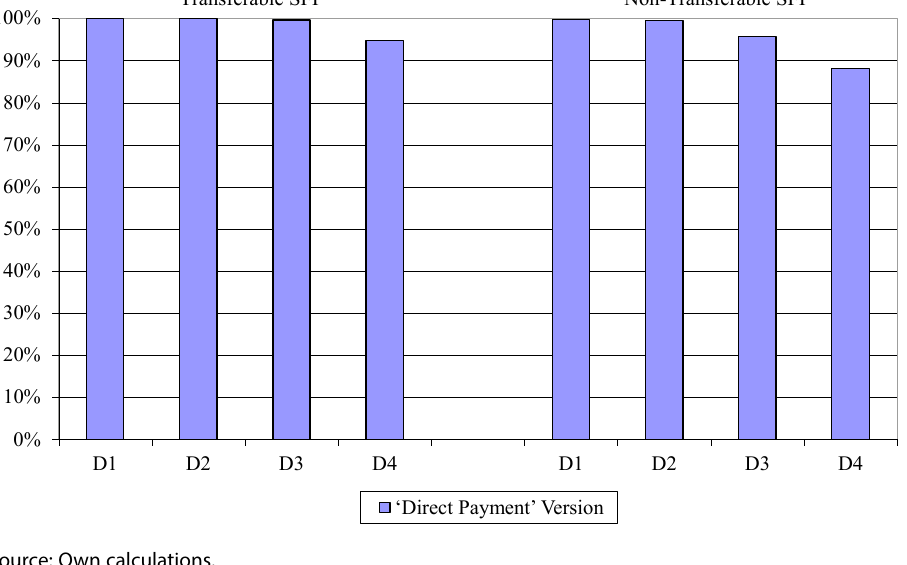
Non-Transferable SFPTransferable SFP